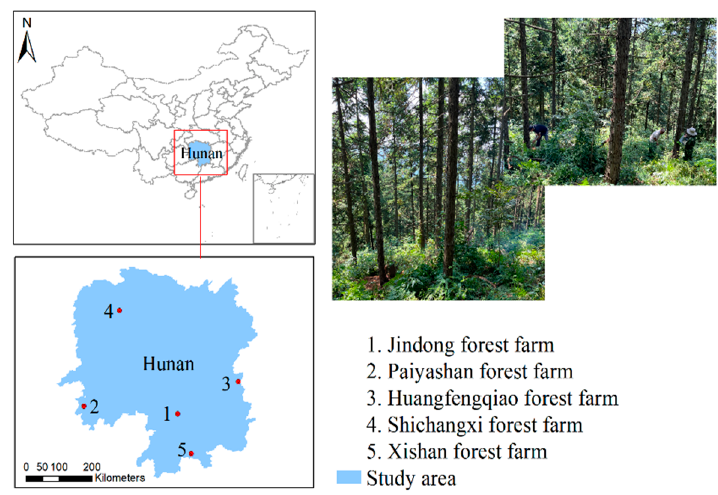
Figure 1. Locations of the temporary observation sample plots.